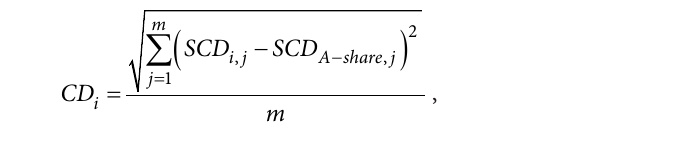
Table 10. Regression results of IPO underpricing using alternative measure of cultural distance (source: authors’